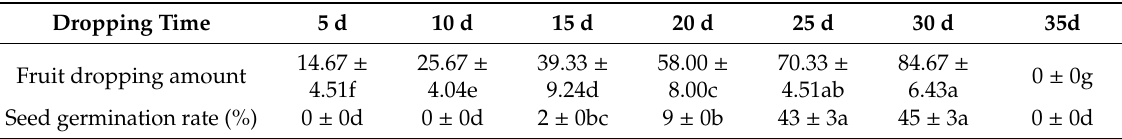
Table 3. Fruit dropping amount and seed germination rate of S. × hainanensis at di ff erent fruit dropping times.